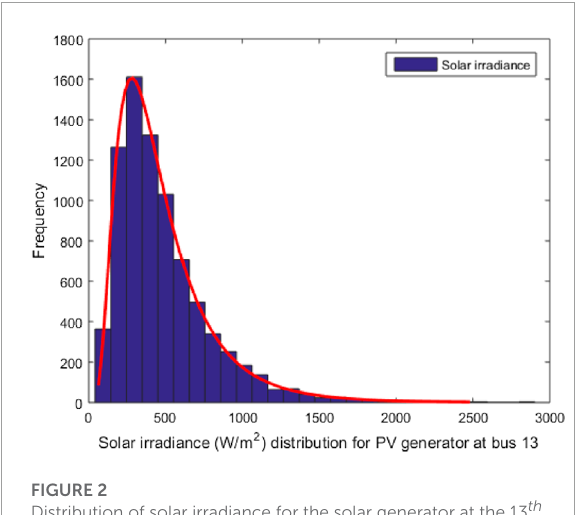
FIGURE 2 Distribution of solar irradiance for the solar generator at the 13 th buses.